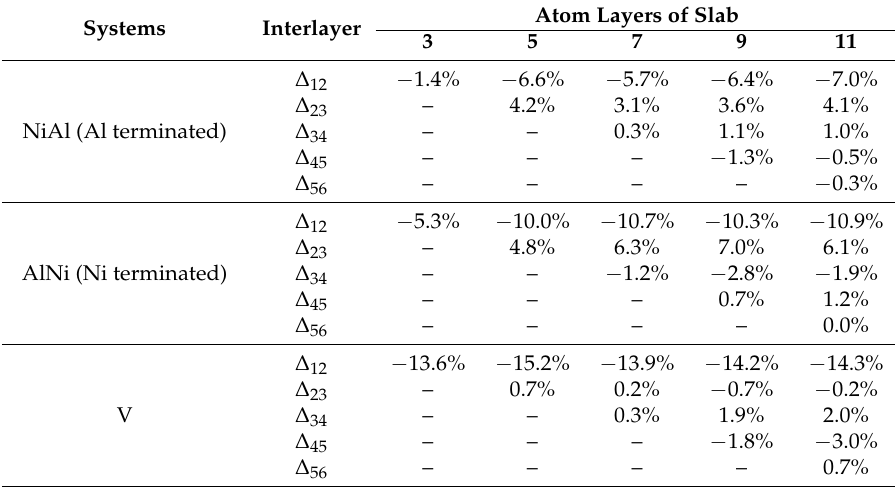
Table 3. The interlayer relaxation change ( ∆ ij ) convergence of NiAl (001), AlNi (001) and V (001) with respect to the atom